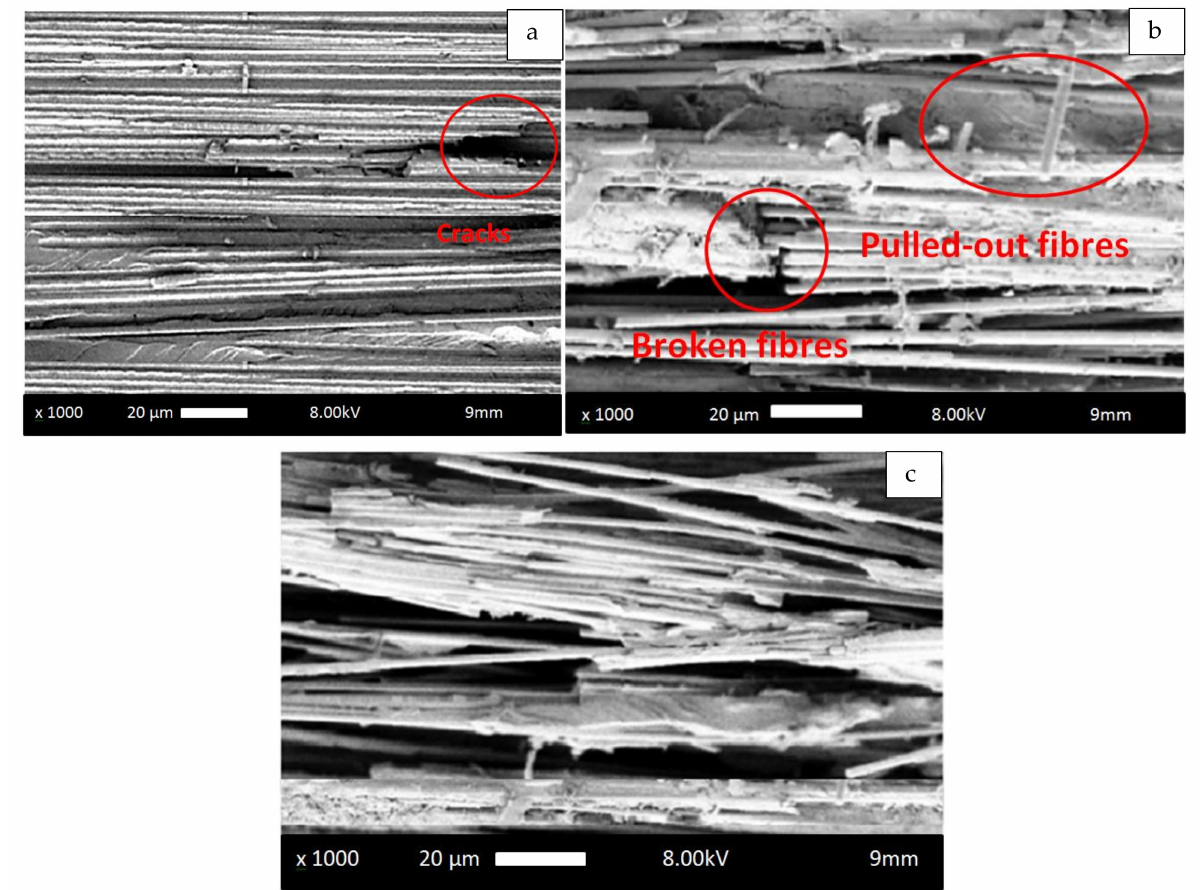
Figure 11. SEM micrographs of the fracture surfaces after tension–tension fatigue testing for ( a ) 20% glass fibre-reinforced polyester, ( b ) 35% glass fibre-reinforced polyester, and ( c ) 50% glass fibre-reinforced